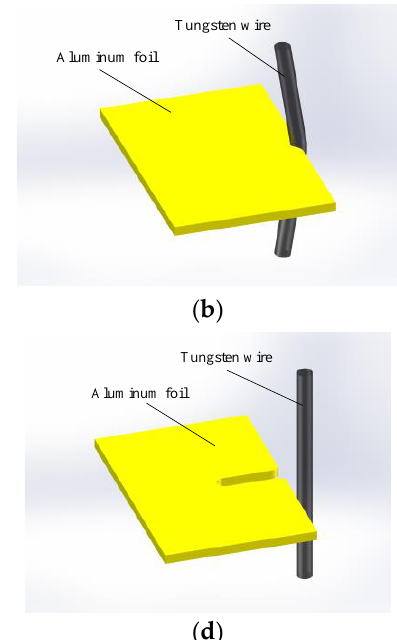
Figure 1. Process of cutting aluminum foil with a tungsten microwire: ( a ) the first step; ( b ) the second step; ( c ) the third step; ( d ) the fourth step.